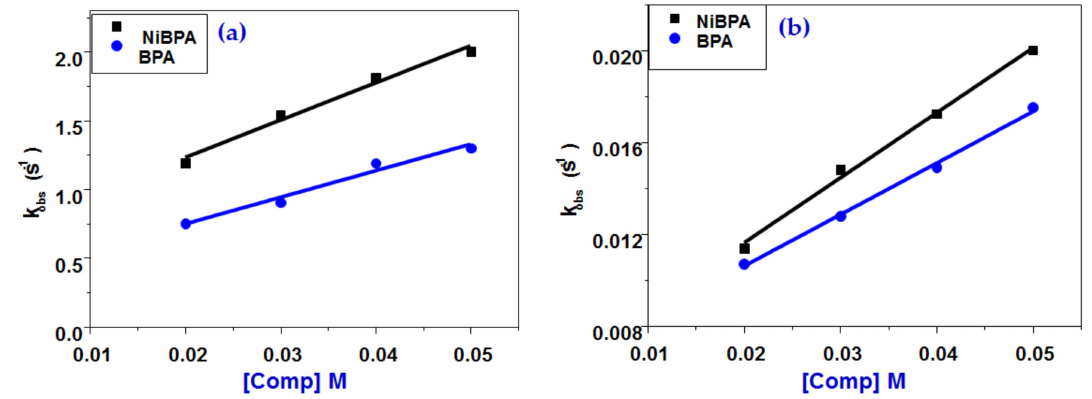
Figure 9. Variation of k obs vs. [ BPA ] and [NiBPA] for ( a ) the first and ( b ) the second interaction steps to ct-DNA.